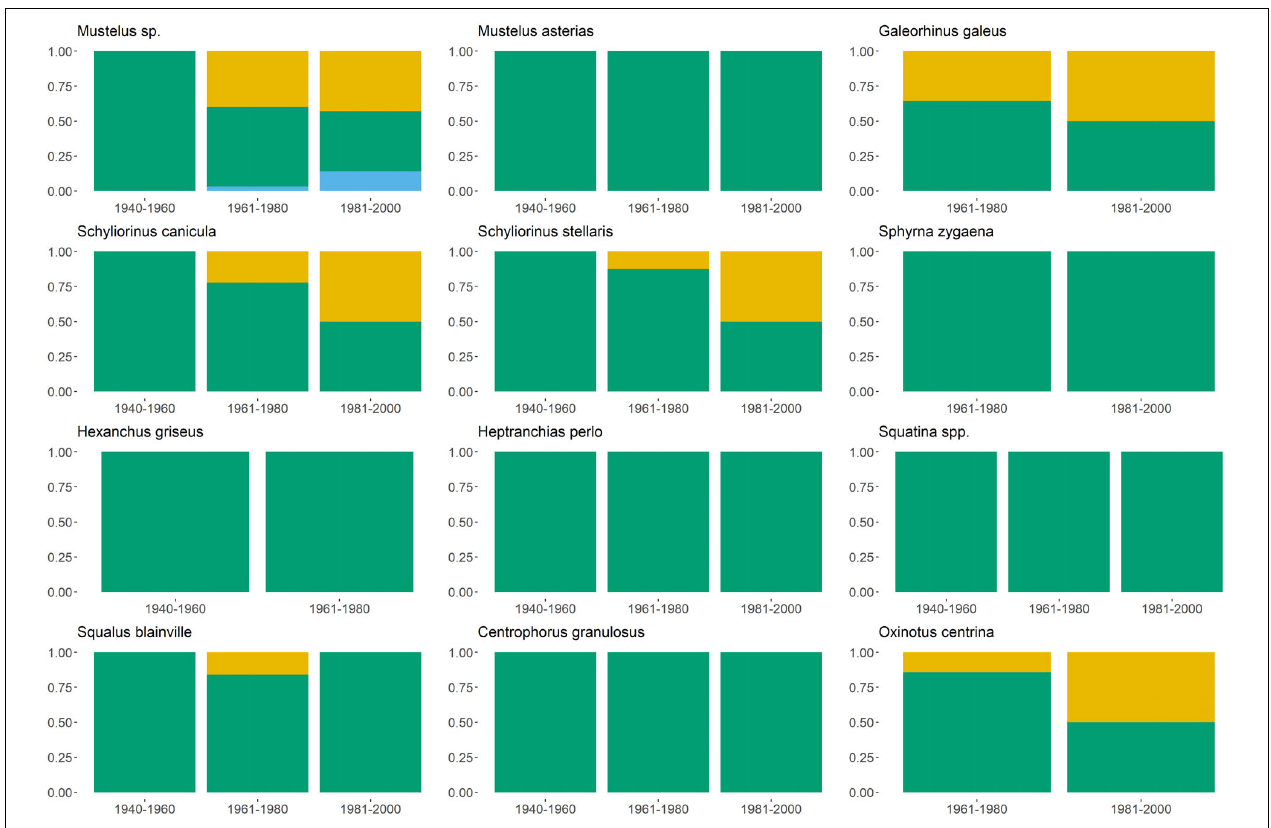
FIGURE 2 | Trends in catches of sharks. Frequencies in the responses to questions on catches by species/taxa and time period. Color legend: green, much more abundant (three times more); yellow, more abundant (two times more); and pale blue, the